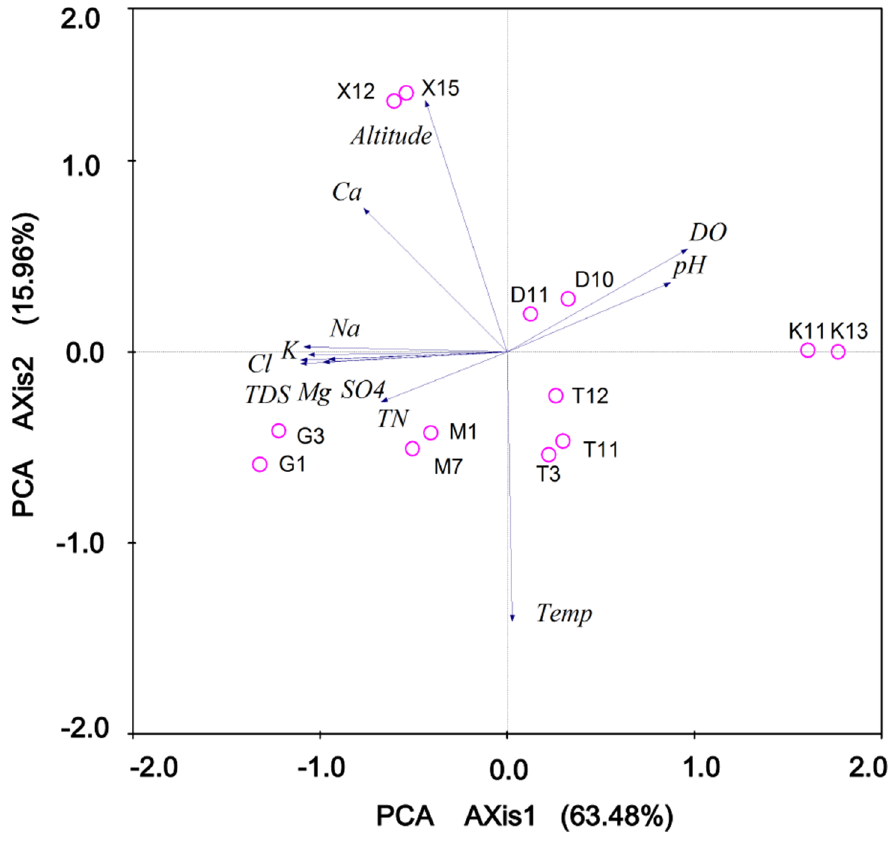
Figure 2. PCA analyses on DO, pH, TN and ion percentages of investigated Tibetan lakes. DO dissolved oxygen, TN total nitrogen, TDS total dissolved solid. K, Na, Ca, Mg, Cl, SO4 was represent for ions potassium (K + ), sodium (Na + ), calcium (Ca 2 + ), magnesium(Mg 2 + ), chloride (Cl 2 ), and sulfate (SO 42 2 ), respectively. The numbers 1 to 13 refer to investigated lakes, Lake Keluke (G1, G3), Lake Gahai (M1, M7), Lake Dasugan (D10, D11), Lake Tuosu (T3, T11, T12), and Lake Keluke (K11, K13),